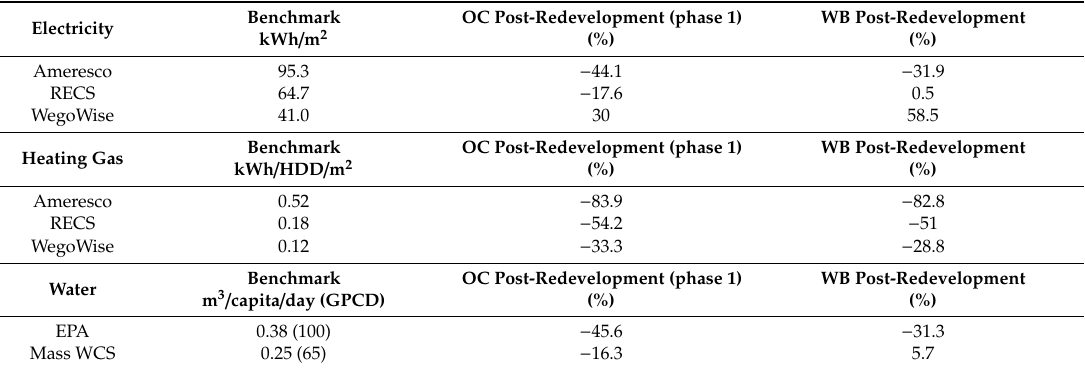
Benchmarking electricity, natural gas for heating, and water consumption in the redeveloped